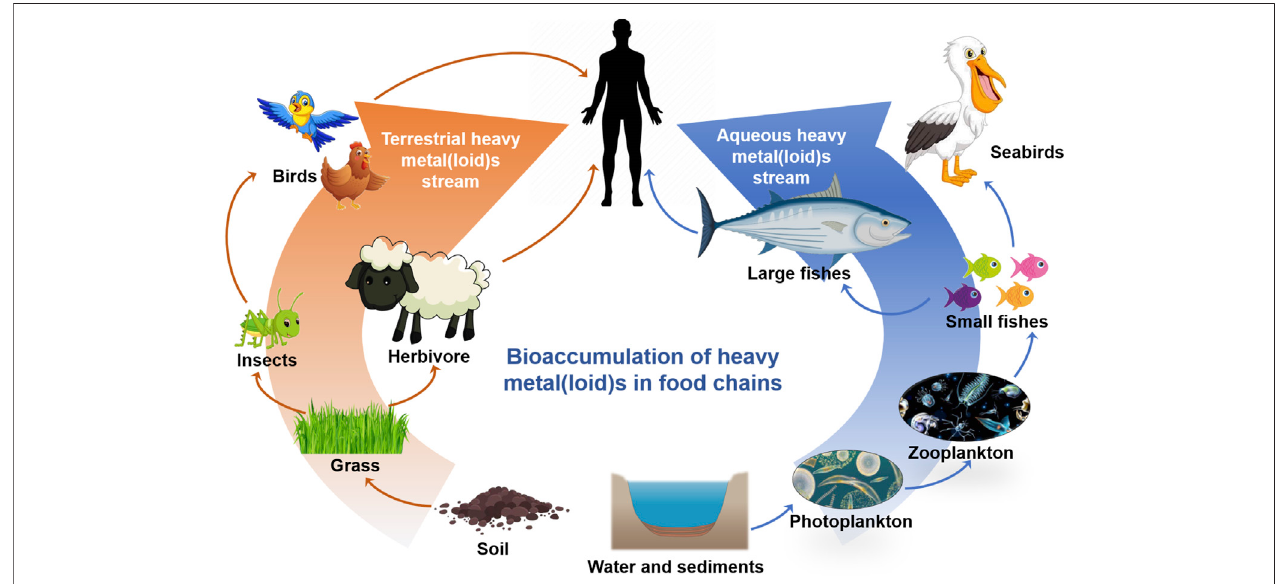
FIGURE 4 | A schematic model of bioaccumulation of HMs in terrestrial and aqueous food chains. The arrow indicates the gradual enrichment of heavy metals.